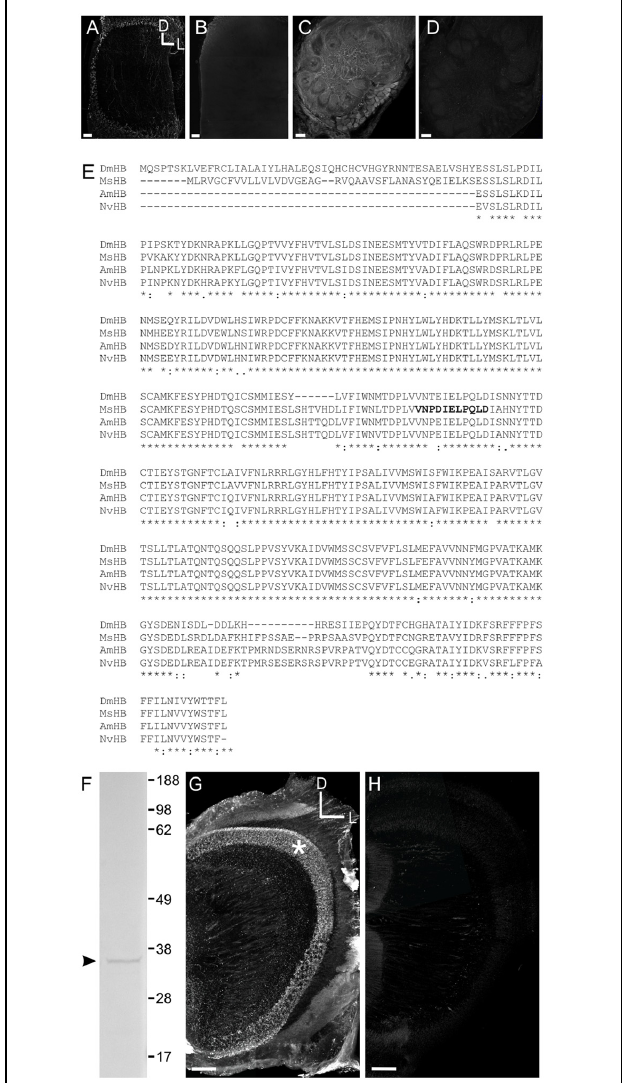
FIGURE 1 | Characterization of the HA GABA and Manduca sexta HA B receptor (MsHisClB) antibodies. (A) HA labeling in control animals where the antibody was not pre-adsorbed. HA labeling in the optic lobe which is the primary neurotransmitter used by arthropod receptor cells. (B) HA labeling in the optic lobe is abolished after the HA antibody was pre-adsorbed with a 10:1 HA to antibody solution. (C) GABA labeling remains in control animals where the antibody was not pre-adsorbed with GABA. (D) GABA labeling in the AL is abolished after the GABA antibody was pre-adsorbed with a 10:1 GABA to antibody solution. For each panel the same dorsal lateral axis is used. (E) Amino acid sequence alignment of the HA B receptor subunits of Manduca sexta (MsHB; Msex2.04603-RA) , Drosophila melanogaster (DmHB; ACA13298.1) , Apis mellifera (AmHB; ABG75740.1), and Nasonia vitripennis (NvHB; ACZ51422.1). Asterisks indicate sequence identity across all four species. Bold font indicates the immunogenic peptide sequence from Manduca that was used to generate the MsHisClB antibody. (F) Western blot using MsHisClB receptor antibody on Manduca brain tissue resulted in a single band at the predicted molecular weight (36 kDa) of the MsHisClB protein. (G) Frontal section of optic lobe depicting MsHisClB-ir in the lamina (as labeled by an asterisks). (H) Pre-adsorption with the immunogenic peptide sequence eliminates all labeling in the lamina. Scale bars = 50 μ m. D, dorsal, L, lateral, A,